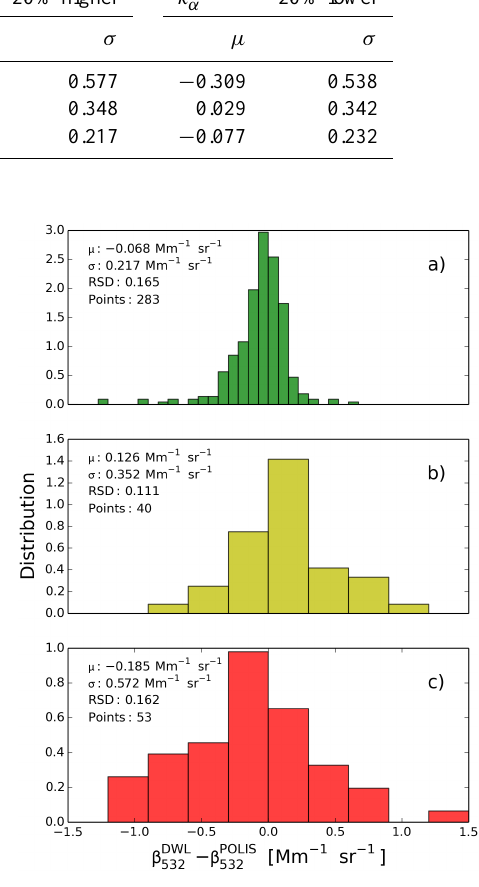
Figure 19. Distribution of the difference between the averaged re- trieved DWL backscatter coefficient profiles and the averaged PO- LIS profiles for each overflight and layer on 26 June, 10 July and 11 July: the upper dust layer (a) , the mixed aerosol layer (b) and the lower marine aerosol layer (c) . Mean difference µ, standard de- viation of the difference σ , relative standard deviation (RSD) of the difference with respect to the mean of backscatter coefficient mea- sured by POLIS and number of data points are given for each